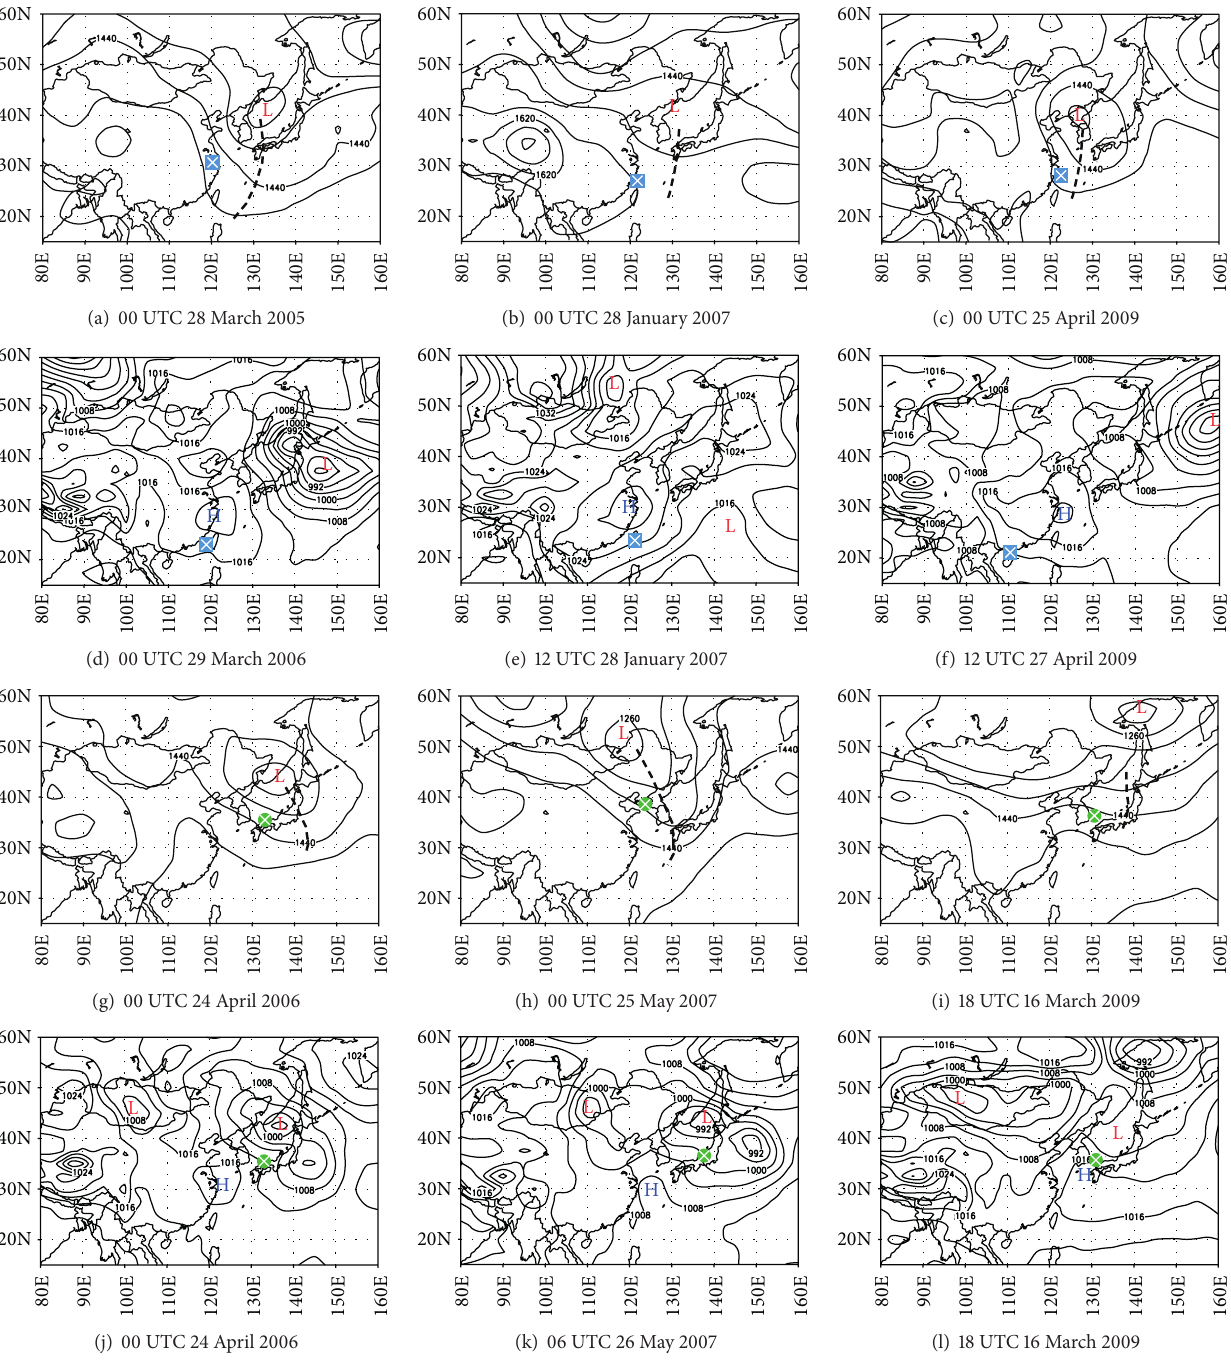
Figure 9: Location of dust parcel relative to 850 hPa and surface synoptic maps over coastal East Asia for other southeastward [(a)–(c) and (d)–(f)] and eastward [(g)–(i) and (j)–(l), respectively] dust events, except the two first events in Figures